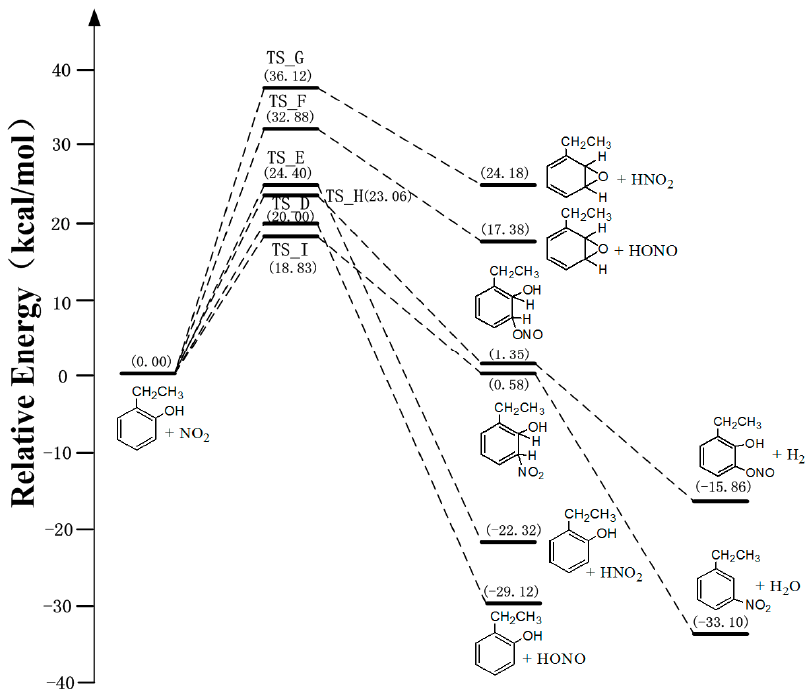
Figure 7. Potential energy surface at the CCSD(T)/6-311++G(d,p)//BHandHLYP/6-311++G(d,p) level of the EB-Ortho reaction with NO 2 , as shown in Figure 2.